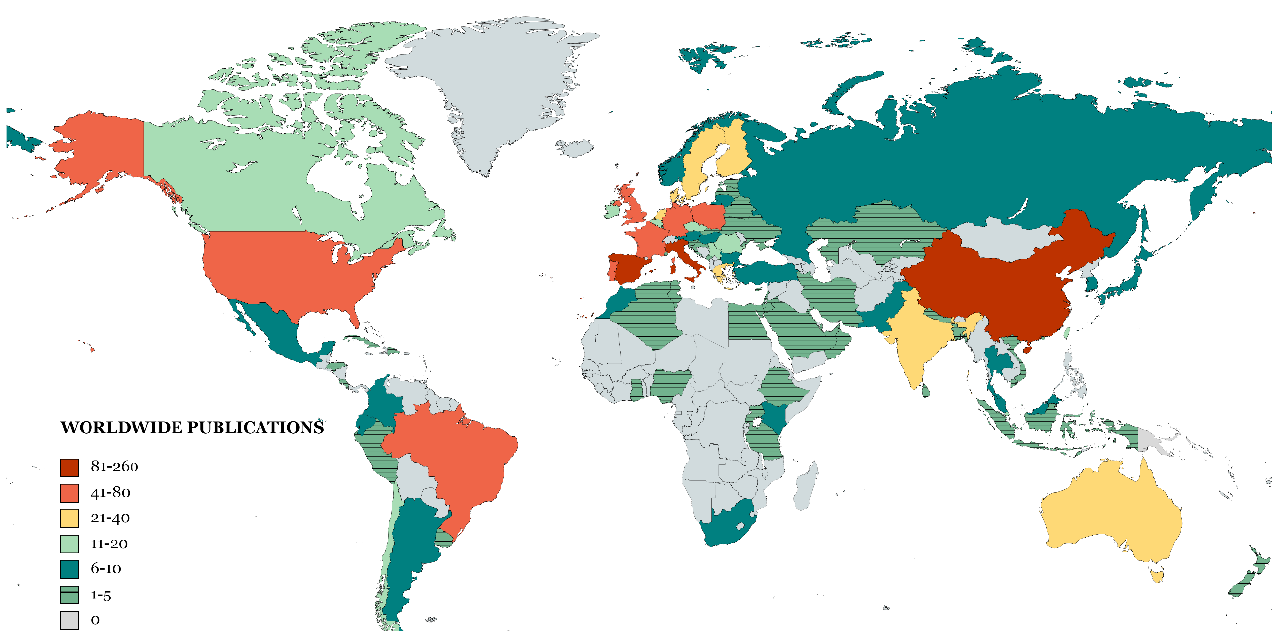
Figure 6. Publications by countries on CE applied to agriculture (2005–2021). Table 6. Main keywords used in research from 2005 to